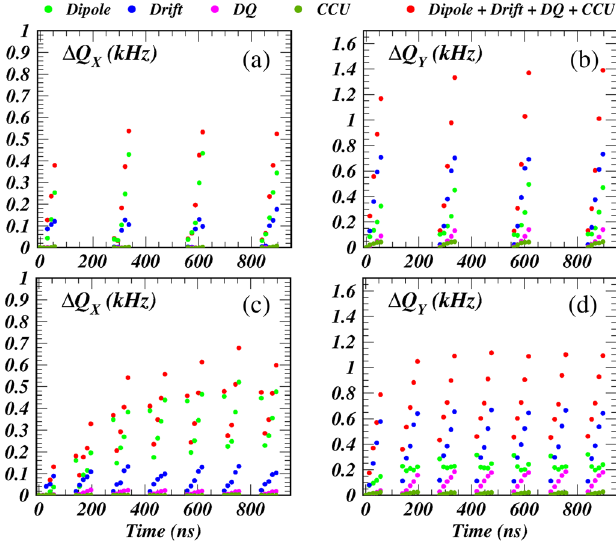
FIG. 31. Modeled tune shifts for the 6.0 GeV CESR upgrade. The upper row shows the tune shifts in the (a) horizontal and (b) vertical planes for the case of nine trains of five bunches with bunch population 7 . 1 × 10 10 . The lower row shows the tune shifts in the (c) horizontal and (d) vertical planes for the case of 18 trains of five bunches with bunch population 3 . 5 × 10 10 . The bunch spacing within trains is 14 ns and the trains are equally spaced around the